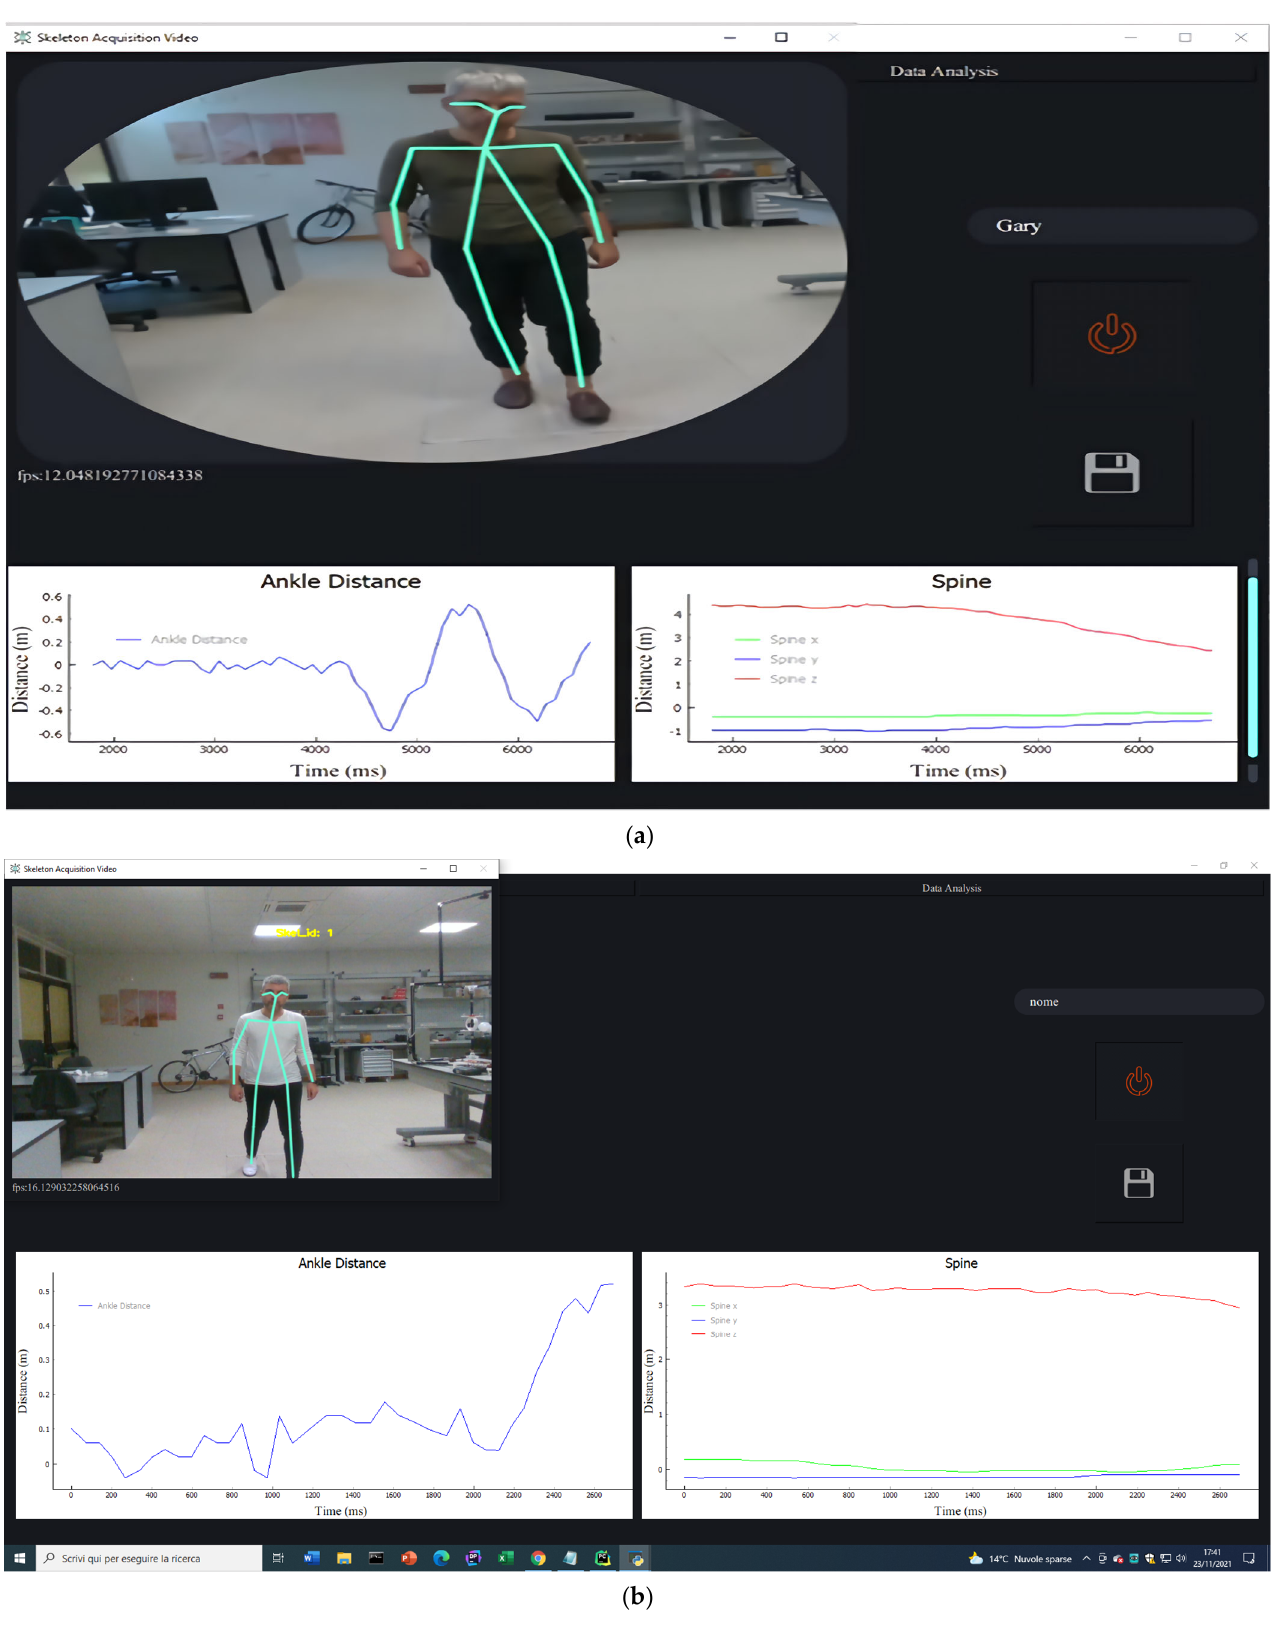
Figure 3. ( a ) SANE’s second prototype at the end of the acquisition of a step. ( b ) Actual SANE’s GUI at the very beginning of a gait cycle acquisition with improved acquisition speed.